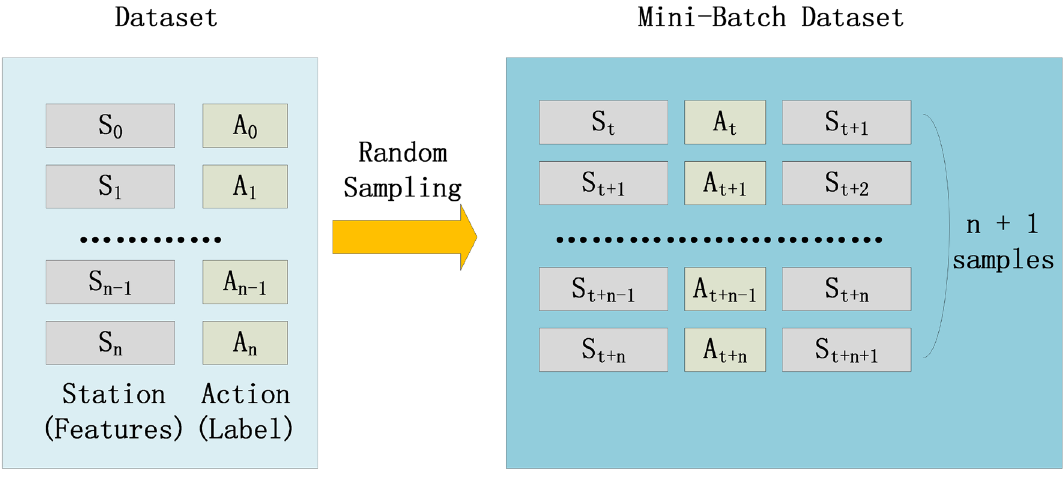
Figure 3. Mini-Batch data encoding schematic for DQN